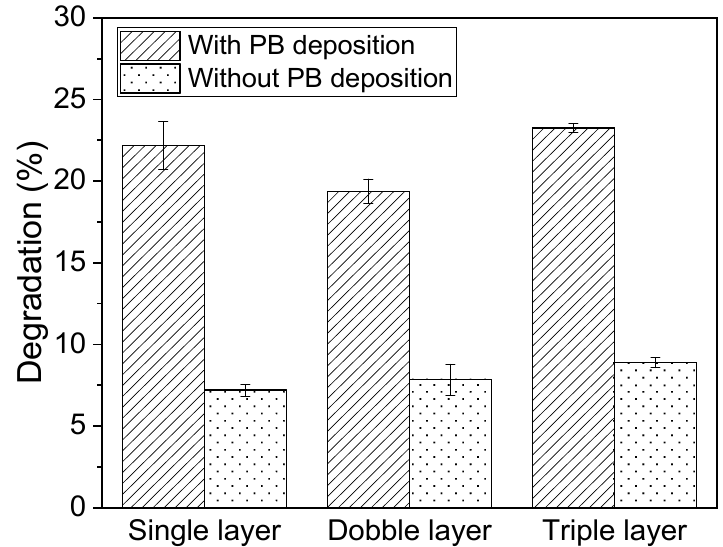
Figure 12. Degradation of three different composite layers on the PB modified GCE before and after running in the Fenton reaction.